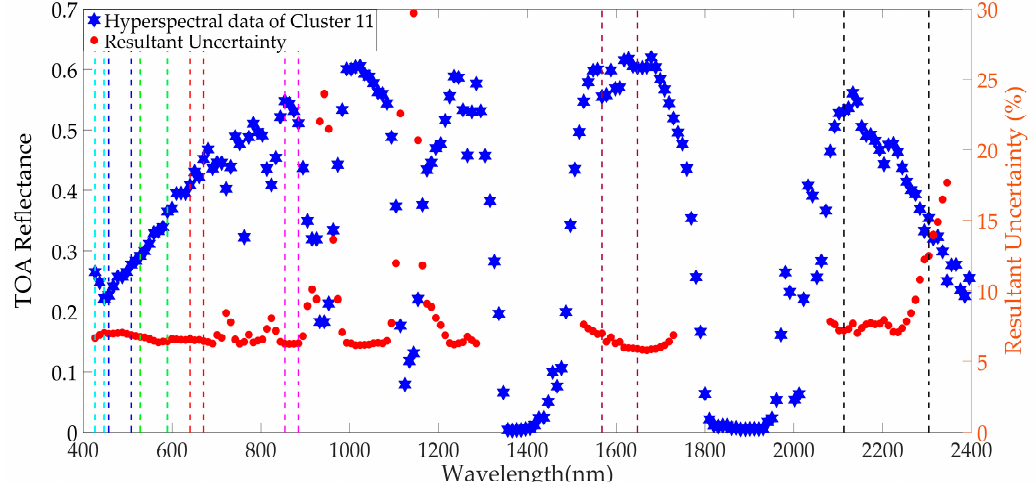
Figure A8. Estimated representative hyperspectral profile of Cluster 10 and its resultant uncertainty.